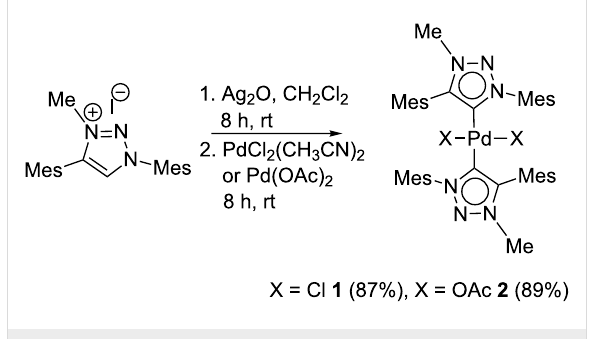
Scheme 1: Synthesis of Pd complexes 1 and 2 .